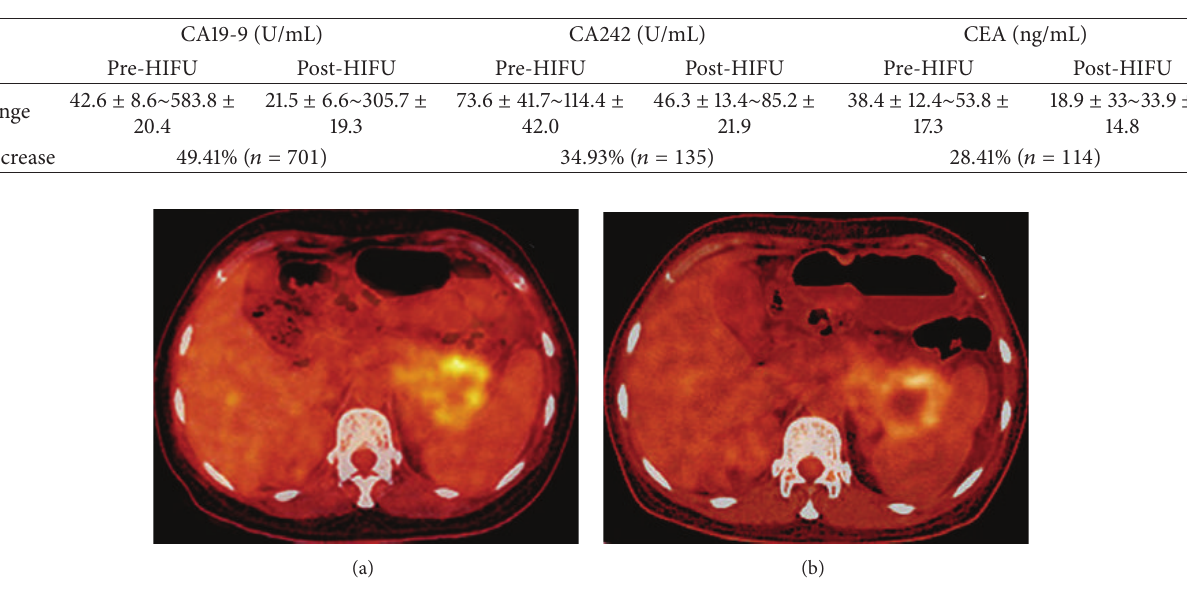
Table 4: Comparison of the serum levels before and after HIFU treatment.